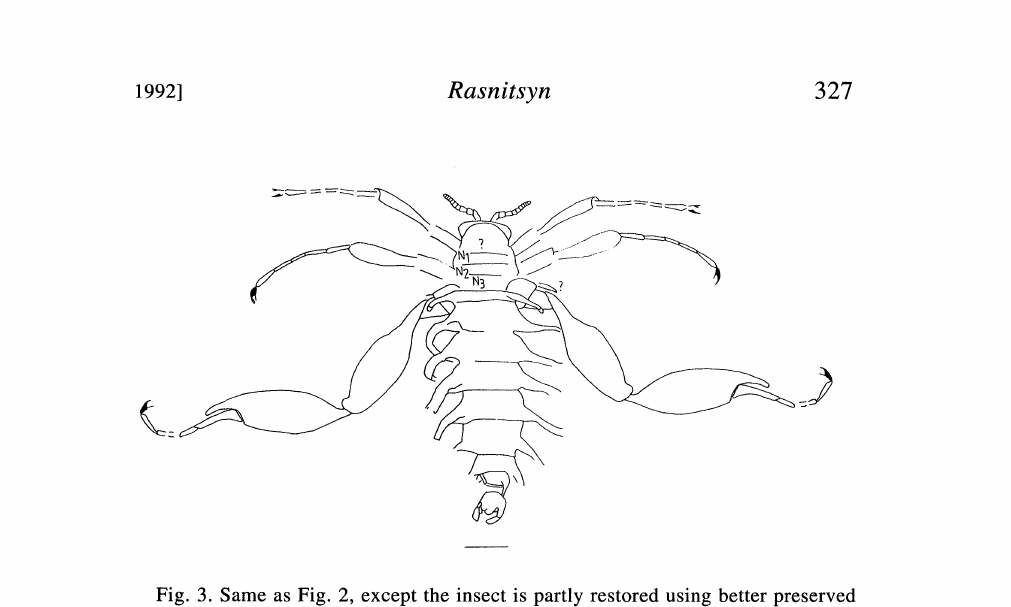
Fig. 3. Same as Fig. 2, except the insect is partly restored using better preserved member of each pair and shown as if seen from above with appendages displaced in more symmetrical position. Abbreviations: N